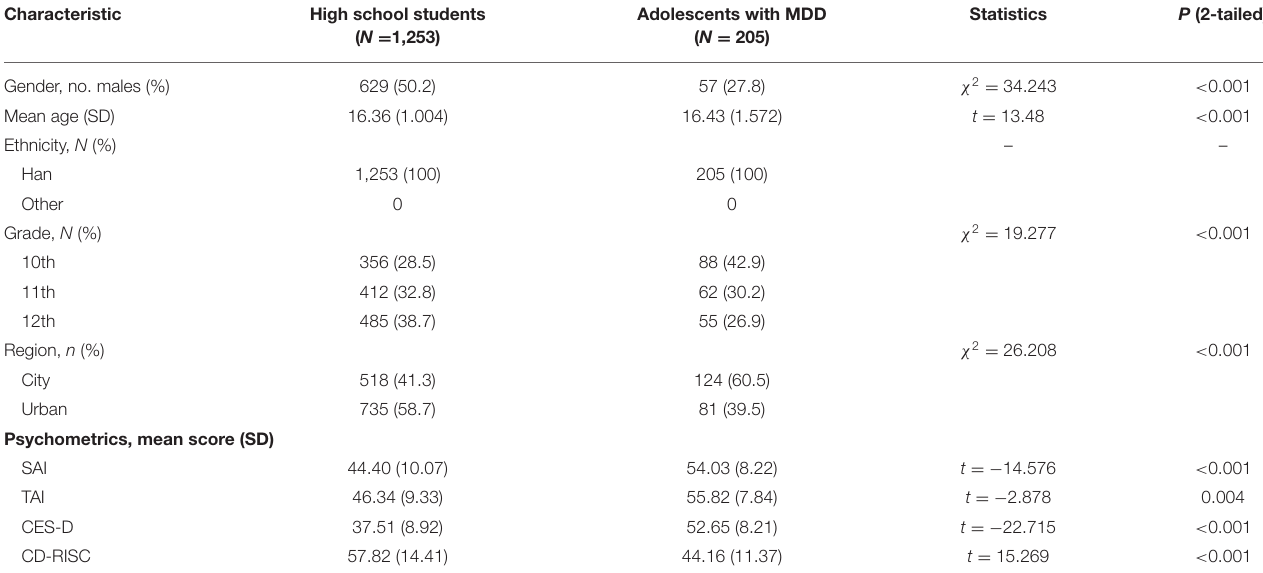
TABLE 1 | Demographic characteristics of